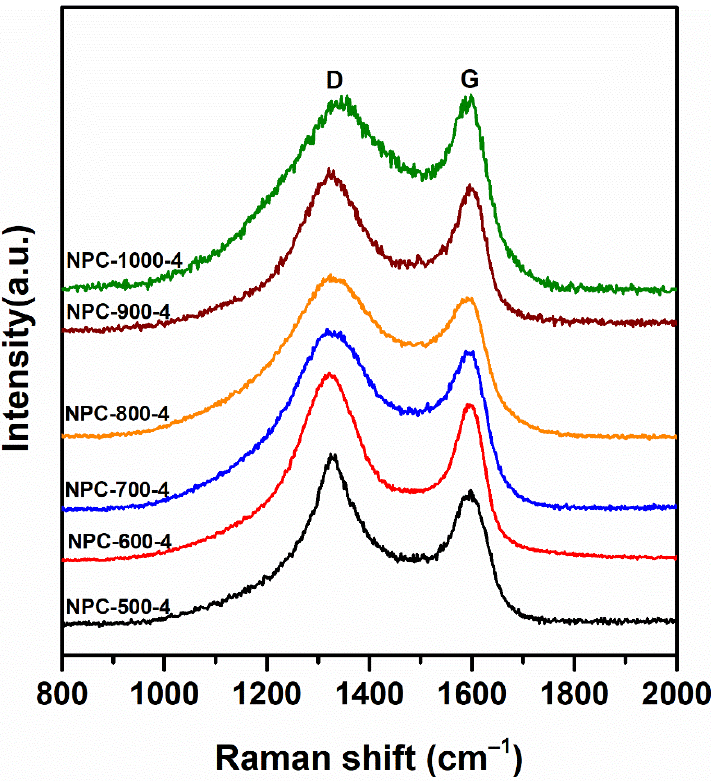
Figure 6. Raman spectra of NPC-y-4.